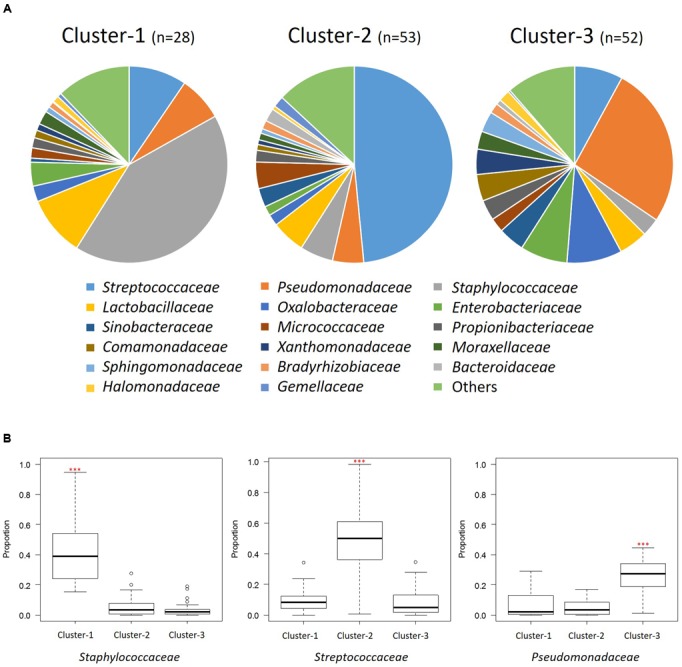
Bacterial community composition of the three clusters at the family level. (A) Pie charts show the mean relative ratios of the bacterial families in each cluster. (B) The relative abundances of the three predominant families in each cluster (∗∗∗P < 0.001 in the Kruskal-Wallis test with FDR correction). Box plot showing the smallest and largest values, 25% and 75% quartiles, the median, and outliers.